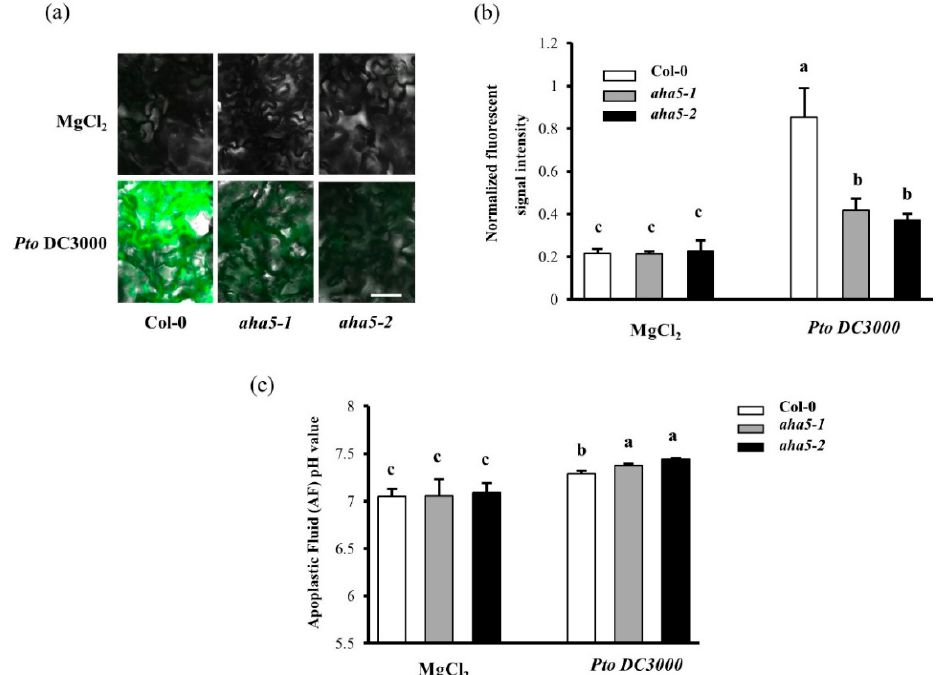
Figure 2. The aha5 mutant plant cells showed lower pH levels in the cytoplasm and higher pH levels of apoplastic fluid in response to the Pto DC3000 treatment. ( a ) The fluorescent image of the cytoplasmic pH alteration in aha5 mutants and WT upon the Pto pathogen infection. The leaves were syringe infiltrated with Pto DC3000 (1 × 10 8 CFU/mL) or 10 mM MgCl 2 . One hour after the treatment, the leaf peel samples were stained with 10 µ M BCECF-AM. The fluorescent signal from BCECF-AM was checked under confocal microscopy through the dual-excitation confocal ratio measurement (488 nm/530 nm). The scale bars indicate 50 µ m. ( b ) The fluorescent signal intensity in ( a ) was determined with ImageJ software. ( c ) The apoplastic fluid pH alteration in aha5 mutants and WT upon the Pto pathogen infection. The leaves were foliar sprayed with 1 × 10 9 Pto